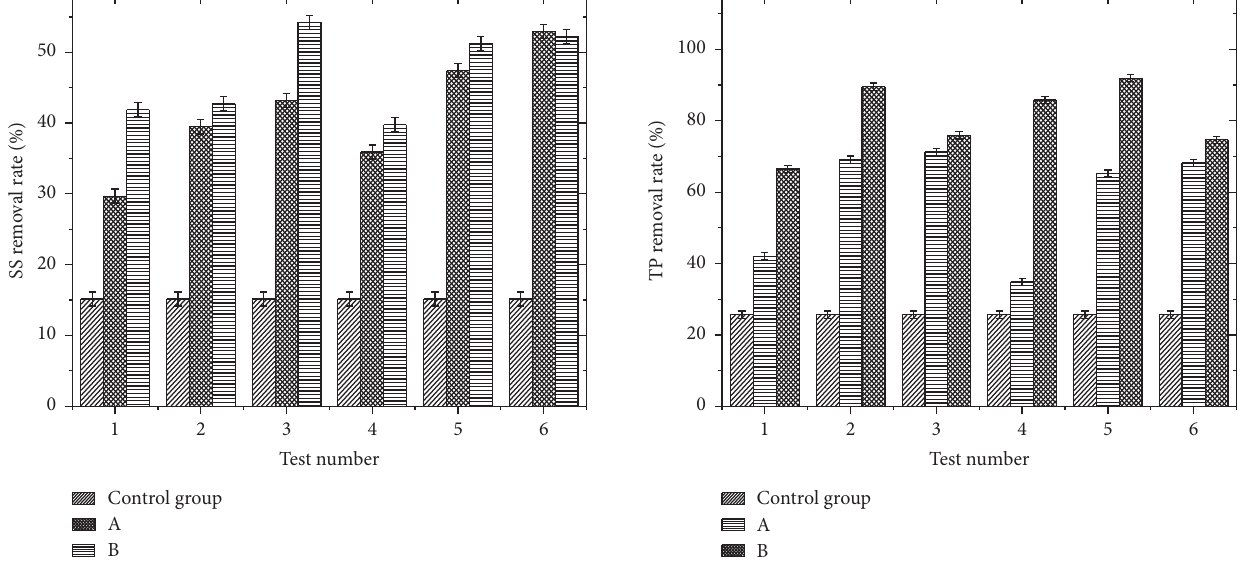
Figure 8: TP purification effect of permeable concrete. Note: A- 1 ∼ A-6: permeable concrete specimens with unmodified diatomite and zeolite powder in different dosages; B-1 ∼ B-6: permeable concrete specimen with modified diatomite and zeolite powder in different dosages.